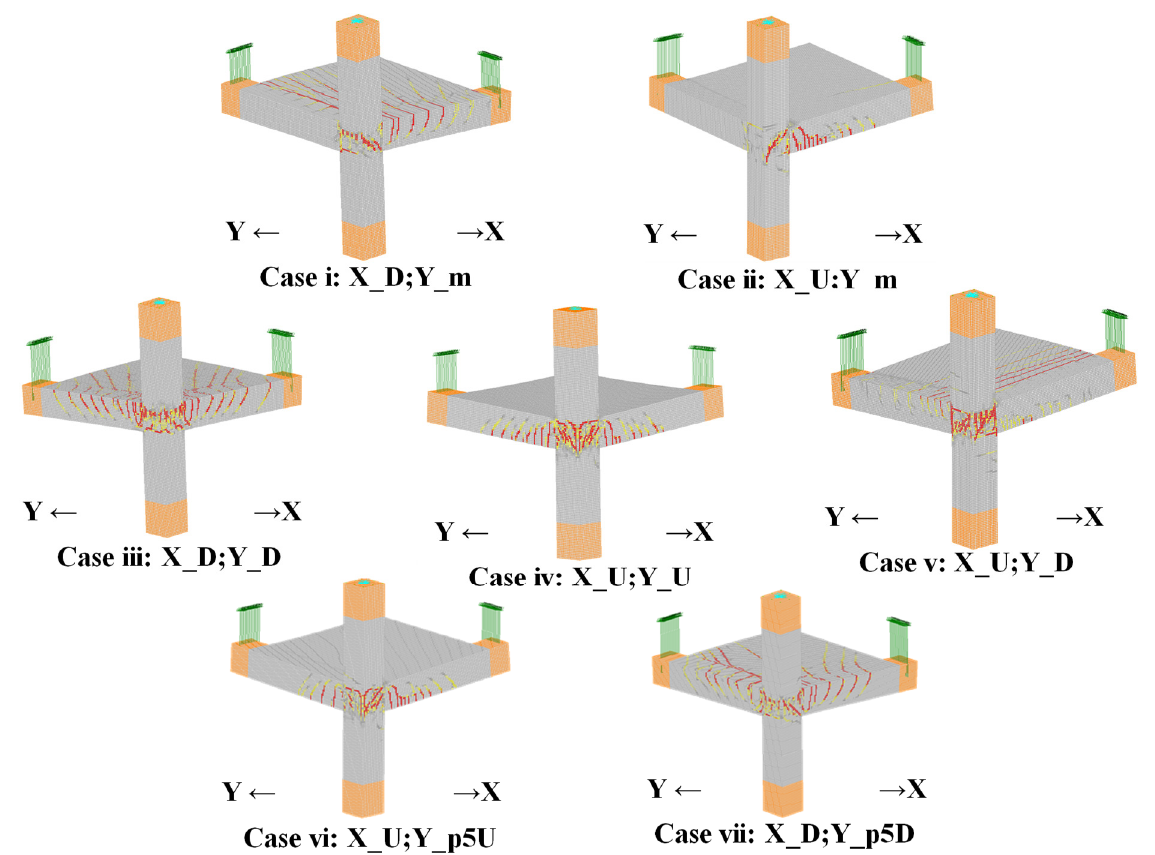
Figure 13. Crack pattern at the joint in all the parametric cases.